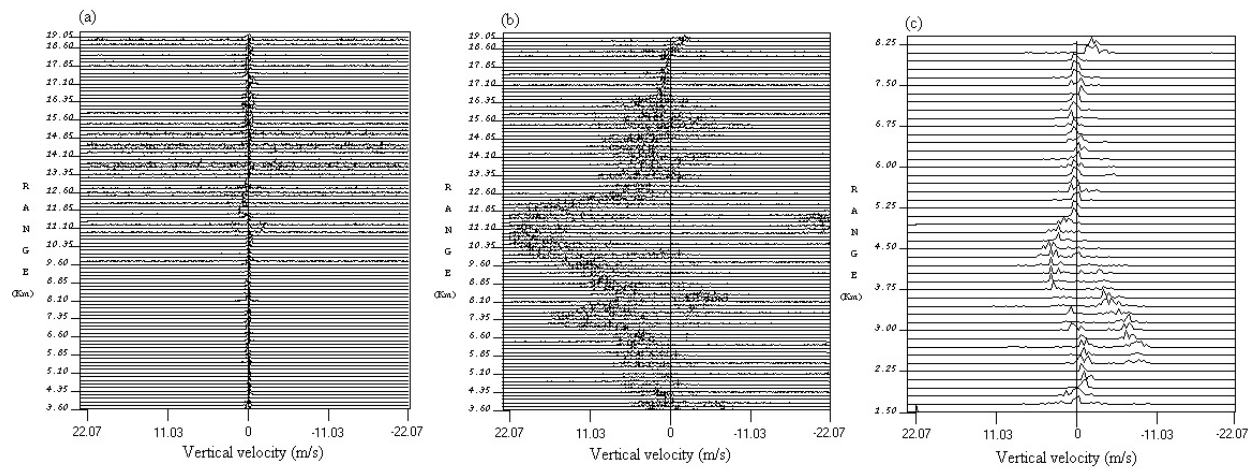
Fig. 2. Typical VHF radar power spectra obtained in (a) clear-air, (b) and (c) in convection environments on 25 May 2002.